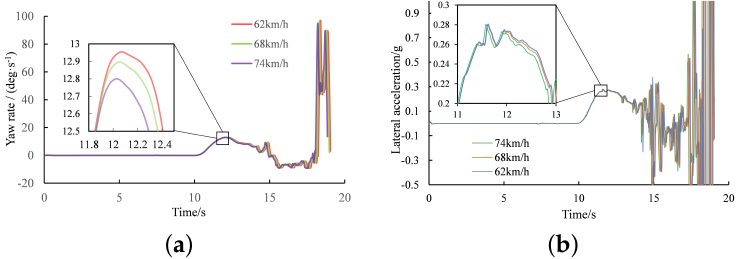
Figure 12. ( a ) Yaw rate and ( b ) lateral acceleration of tractor-trailer for driving speeds over 40 km/h.